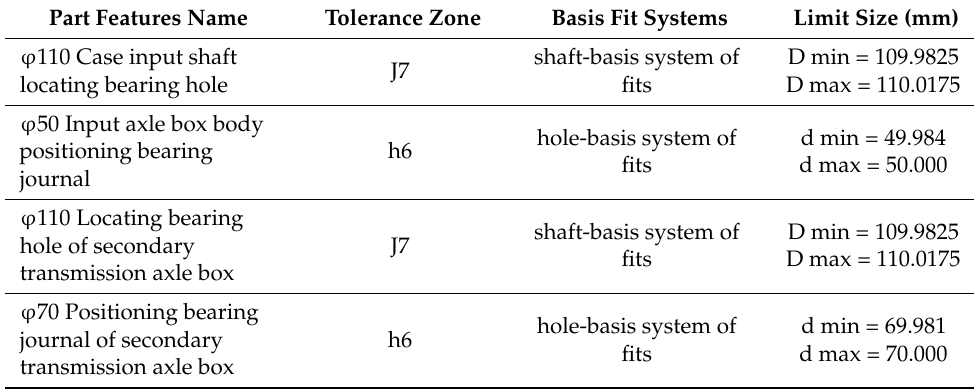
Table 10. Production process statistics table in the knowledge base. Table 11. Fit tolerance data of key